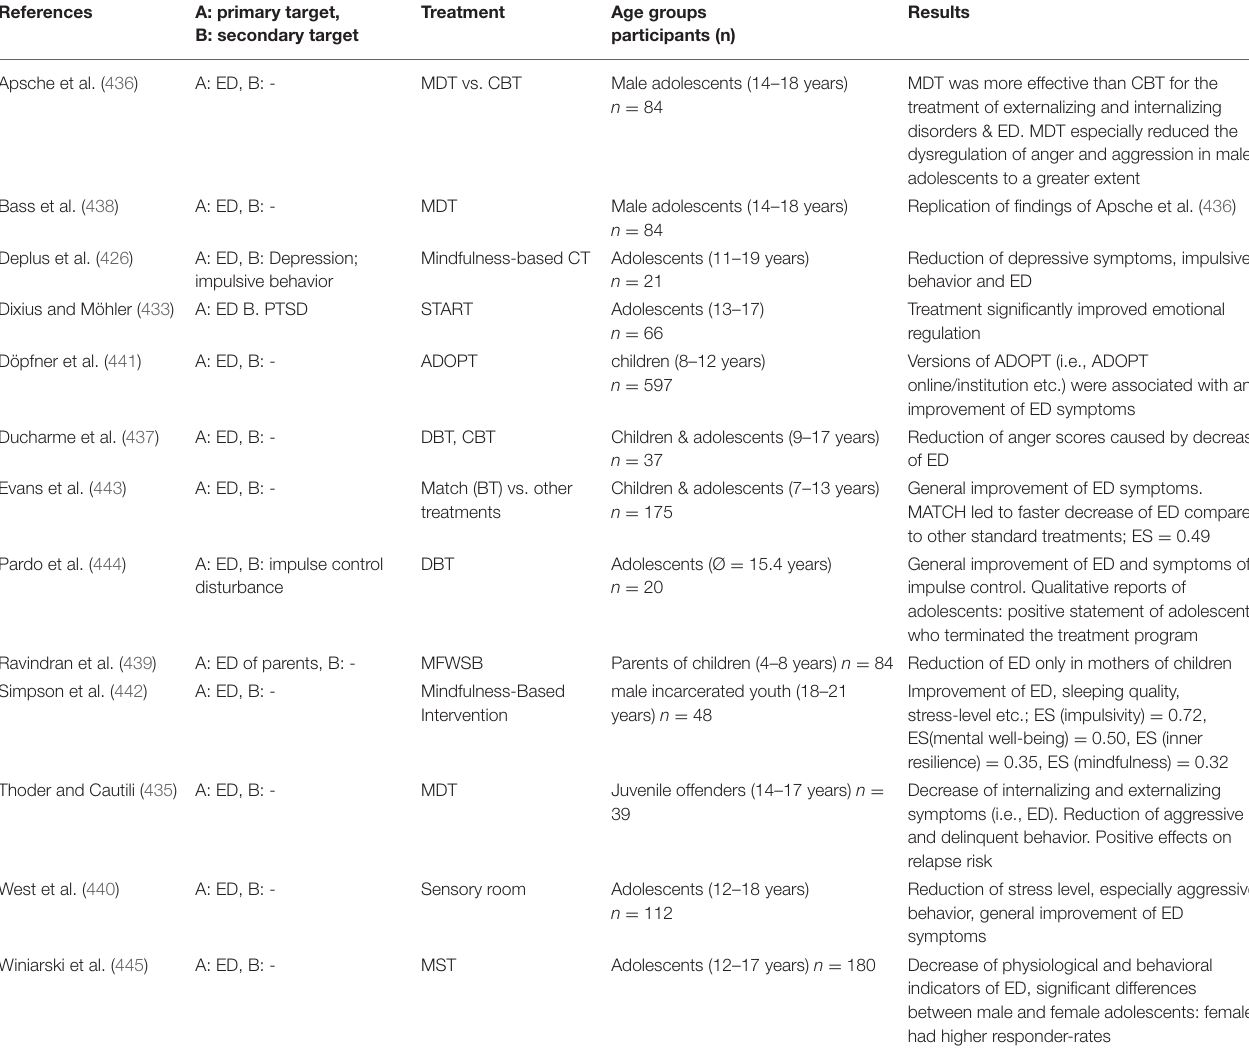
TABLE 1 | Clinical trials focusing on ED as primary